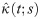
Intraday kurtosis v time t.The black dots represent κ^(t;s) averaged over the semesters (excluding those in the interval between s = 11 and s = 16). For mere comparison purposes, we present κ˜(t;s) using the grey symbols as well. The dashed red line represents the value of the kurtosis for Gaussian distributed variables.